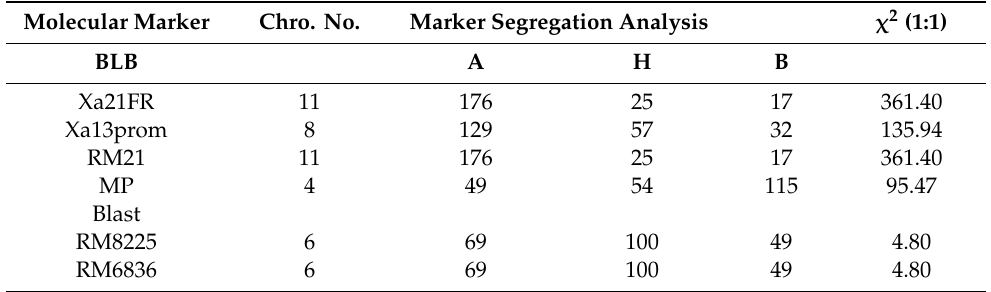
Figure 3. Confirmation of blast resistance in homozygous improved lines using the SSR marker RM6836. Table 3. Foreground marker segregation analysis of the BC 2 F 2 progenies.